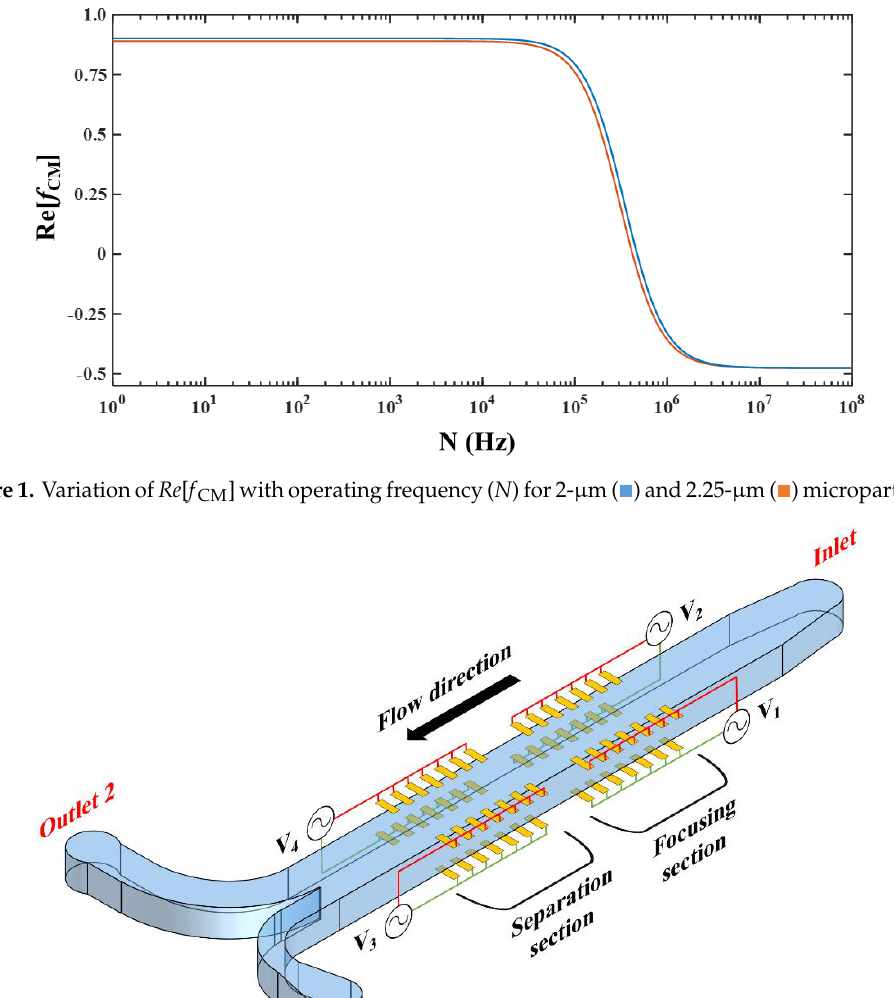
Figure 1. Variation of Re [ f CM ] with operating frequency ( N ) for 2-μm ( ■ ) and 2.25-μm ( ■ ) microparticles.